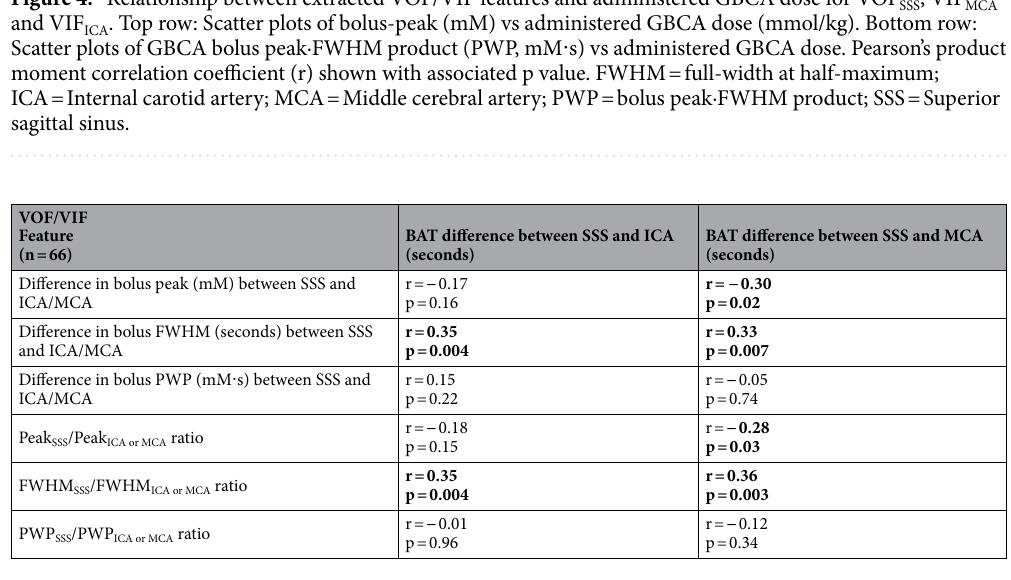
Table 2. Relationship between the GBCA bolus arrival time delay and differences in semiquantitative parameters between the arterial (ICA, MCA) VIFs and venous (SSS) VOF. Significant values are in [bold]. Pearson’s product moment correlation coefficient (r) shown with associated p value. BAT Bolus arrival time, ICA Internal carotid artery, MCA Middle cerebral artery, PWP Bolus peak∙FWHM product, SSS Superior sagittal sinus, VIF Vascular input function, VOF Vascular output function.